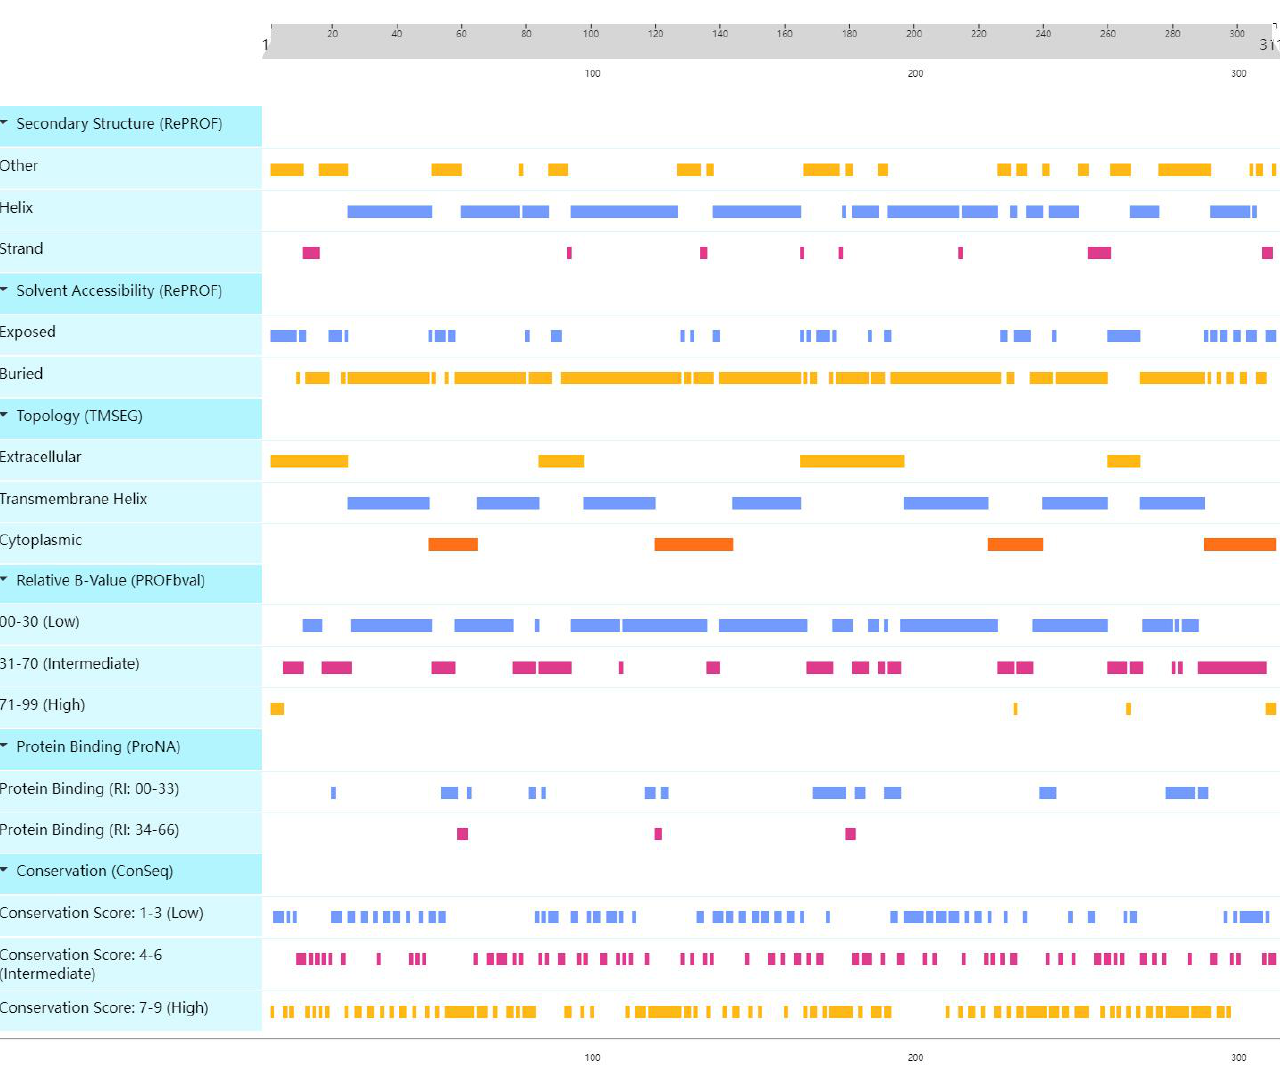
Figure 2. Structure information of ORs of the giant panda. Table 1. Summary of the olfactory receptor (OR) genes in six Ursidae